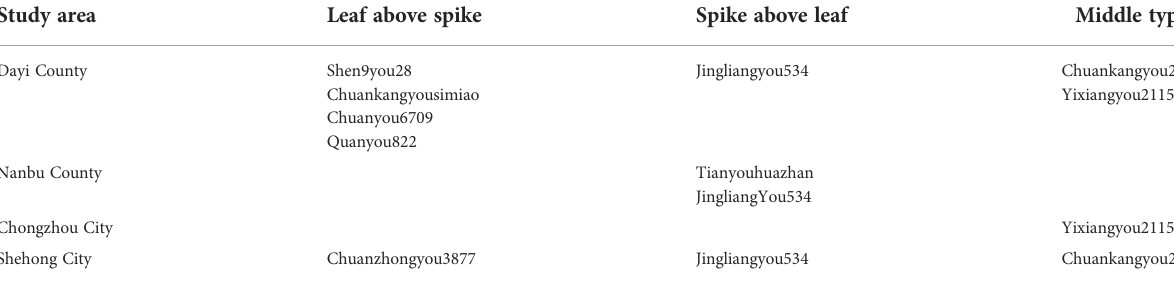
TABLE 1 Experimental rice varieties and their classi fi cations. Study area Leaf above spike Spike above leaf Middle type